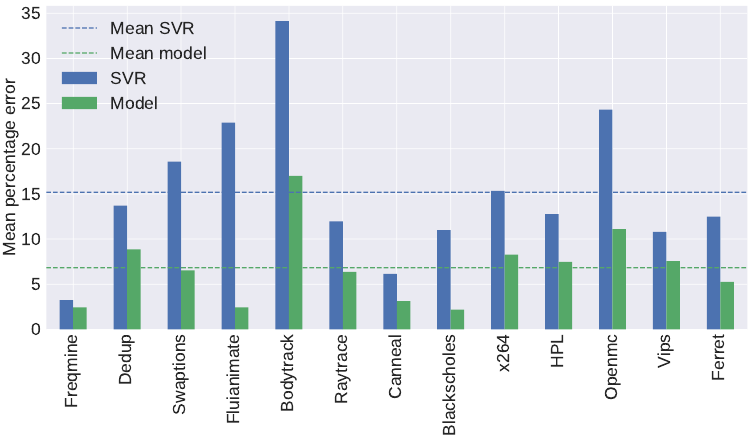
Figure 9. Comparison of the mean percentage error between the proposed model and SVR. “Model mean” and “SVR mean” are the average of all MPE values for all